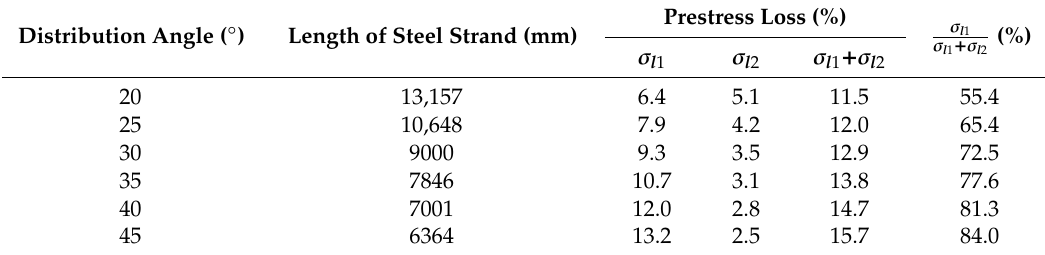
Table 9. Theoretical prestress loss of steel strands given the slab width of 4.5 m.